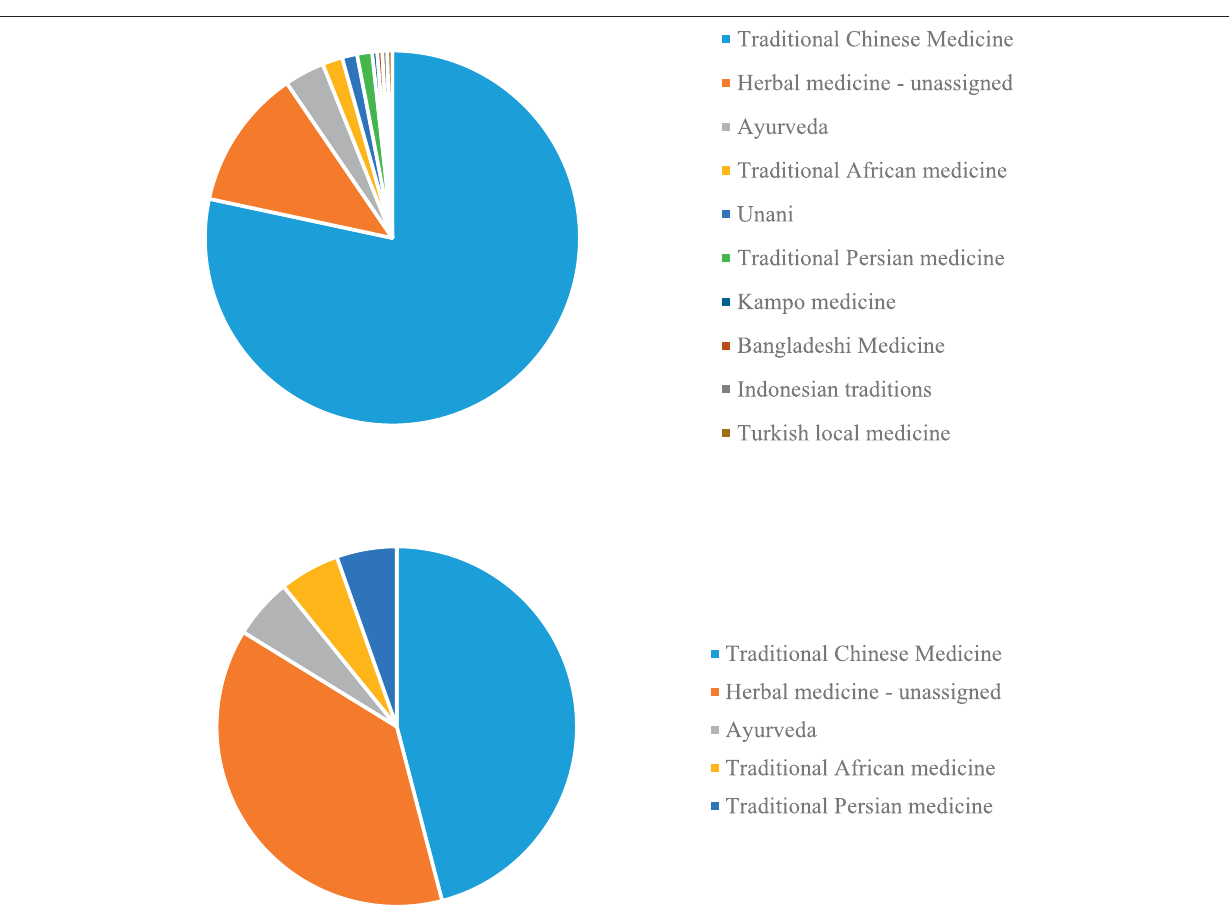
Frontiers in Pharmacology |